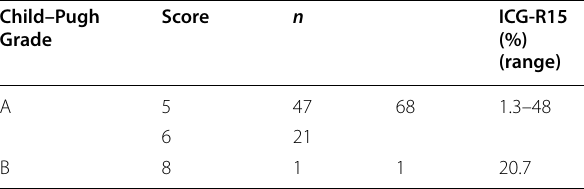
ICG-R15: 15-min indocyanine green retention rate